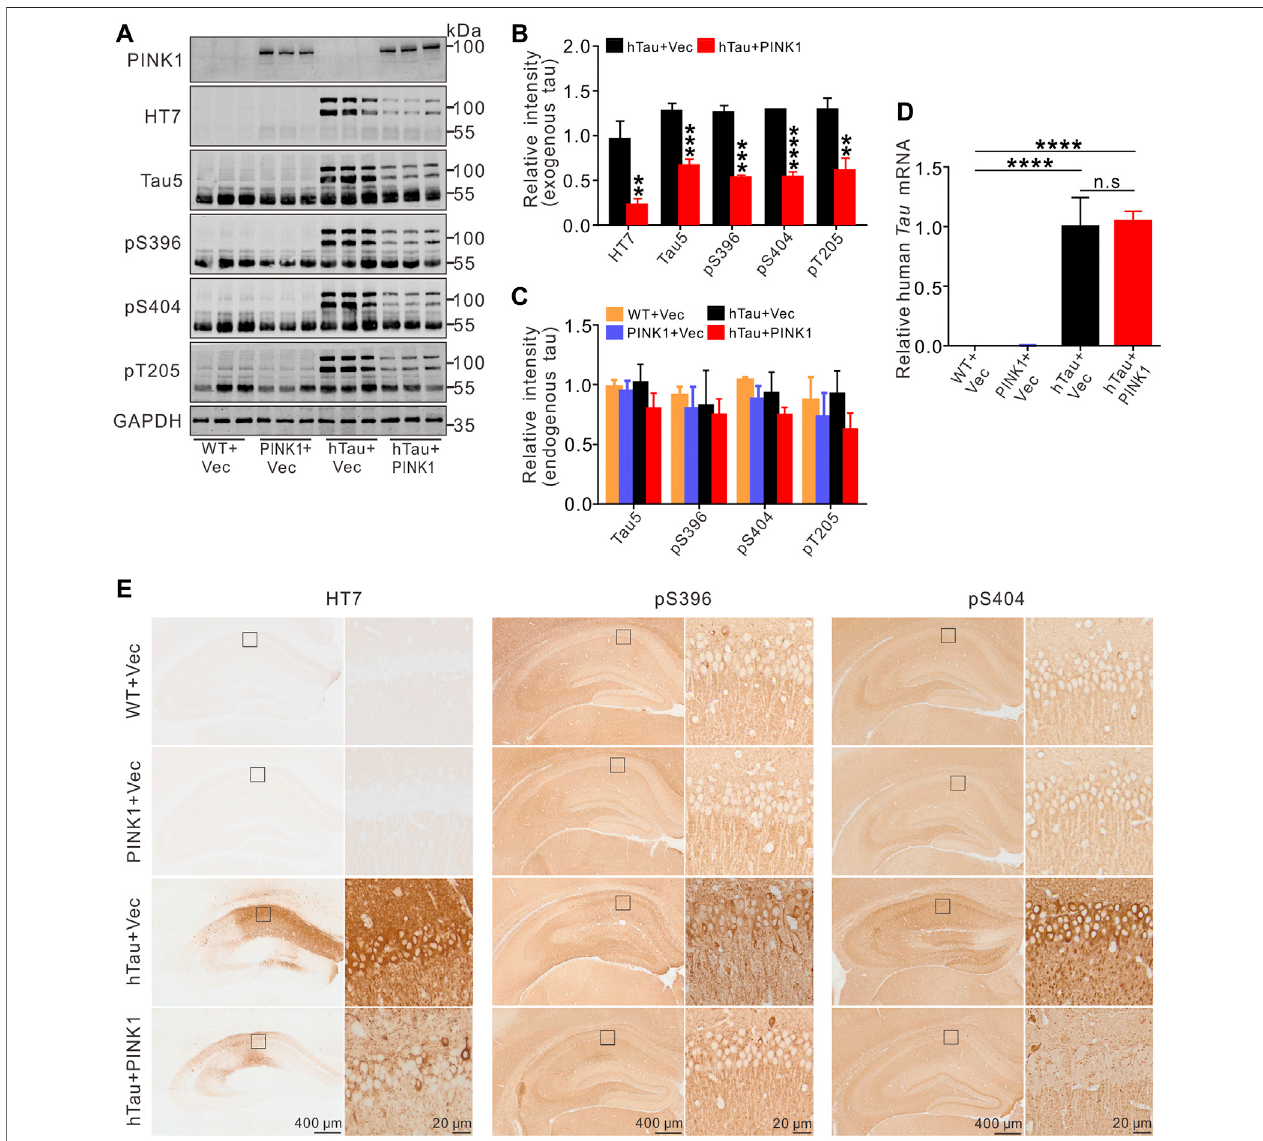
FIGURE 4 | Overexpression of PINK1 decreases tau protein levels in hTau mice. (A,B) Representative images and quantitative analysis of Western blot showed overexpressionofPINK1diminishedlevelsofexogenoustau( ∼ 106 kDa,humantau),includingtotaltau(HT7,Tau5)andphosphorylatedtau(pS396,pS404,andpT205) in the hippocampal CA1 area of hTau mice. Unpaired t -tests. ** p < 0.01, *** p < 0.001, **** p < 0.0001. (C) Signi fi cant alteration of endogenous tau ( ∼ 55 kDa) was not found among the four groups. One-way ANOVA followed by Tukey multiple-comparisons tests. (D) The levels of human TAU mRNA had no signi fi cant changes with PINK1 overexpression. One-way ANOVA followed by Tukey multiple-comparisons tests. **** p < 0.0001. (E) Representative images of immunohistochemical staining showed PINK1 reduced tau pathology (total tau, phosphorylated tau at Ser396 or Ser404) in the hippocampal CA1 area. HT7 antibody exclusively reacts to human tau proteins. All data were presented as mean ± SD. n (cid:2) 3 mice for each group.